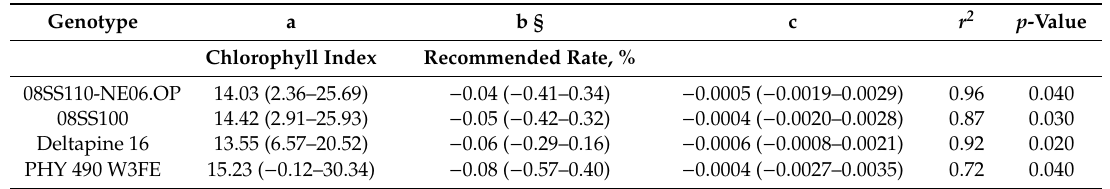
Table 11. Quadratic equation constants and coe ffi cients of determination for chlorophyll index (Chl) of four cotton genotypes to nitrogen treatment measured at 60 days after planting.